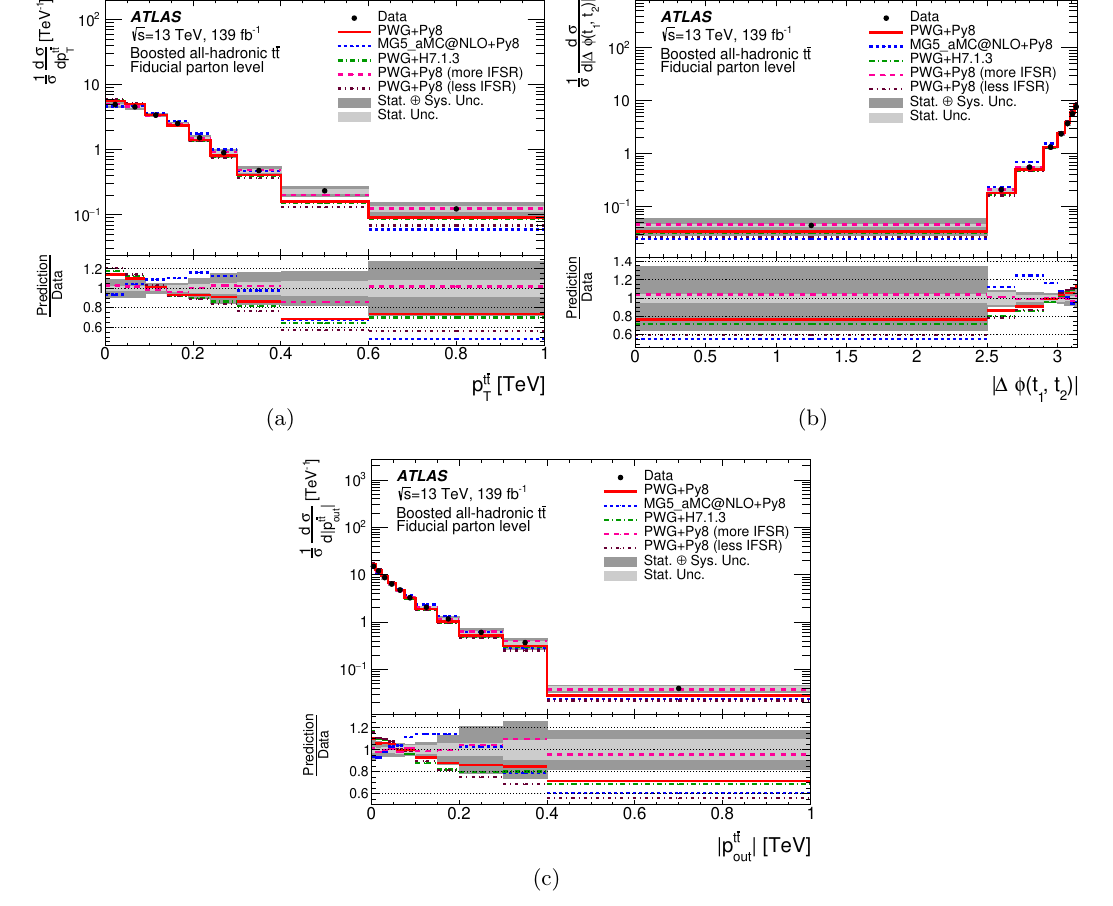
Figure 24 . Normalized parton-level differential cross-sections as a function of (a) the p T of the t ¯ t system, p t ¯ t , (b) the azimuthal angle between the two top quarks, ∆ φ t ¯ t , and (c) the absolute value T of the out-of-plane momentum, p t ¯ t . The dark and light grey bands indicate the total uncertainty out and the statistical uncertainty, respectively, of the data in each bin. Data points are placed at the centre of each bin. The Powheg+Pythia 8 MC sample is used as the nominal prediction to correct the data to parton